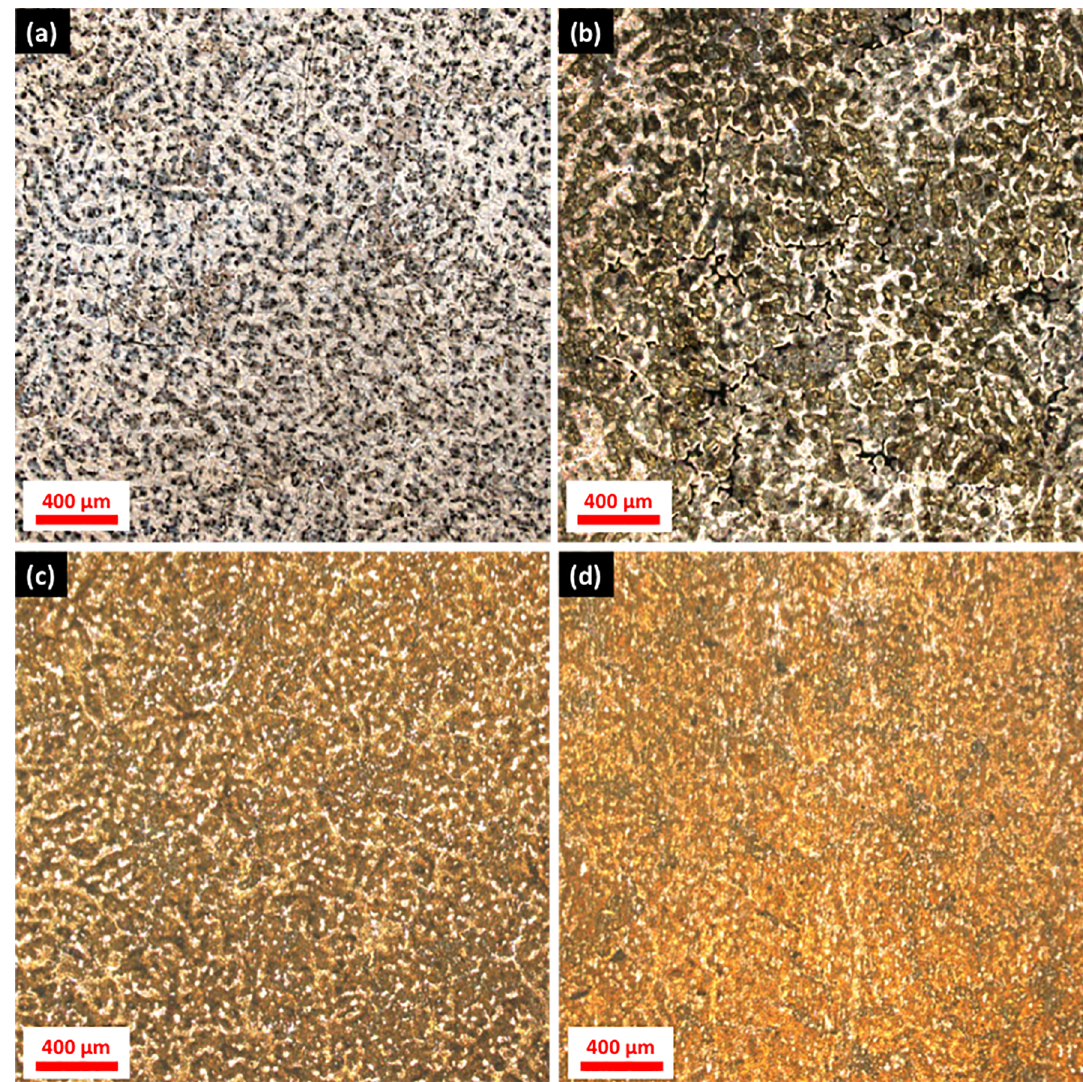
Figure 1. CLSM micrographs for the AZ91D alloy in the a) uncoated and cerium-coated conditions: b) 20 s; c) 60 s and d) 120 s.